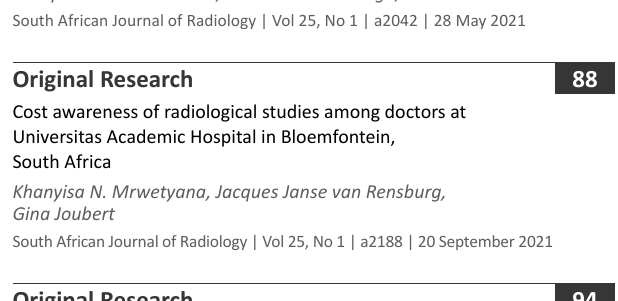
MRI findings in chronic exertional compartment syndrome of the forearm: Using signal intensity ratio as a diagnostic tool Jacques Badenhorst, Mark Velleman, Audrey Jansen van Rensburg, Tanita Botha, Nikki van der Walt, Christa Janse van